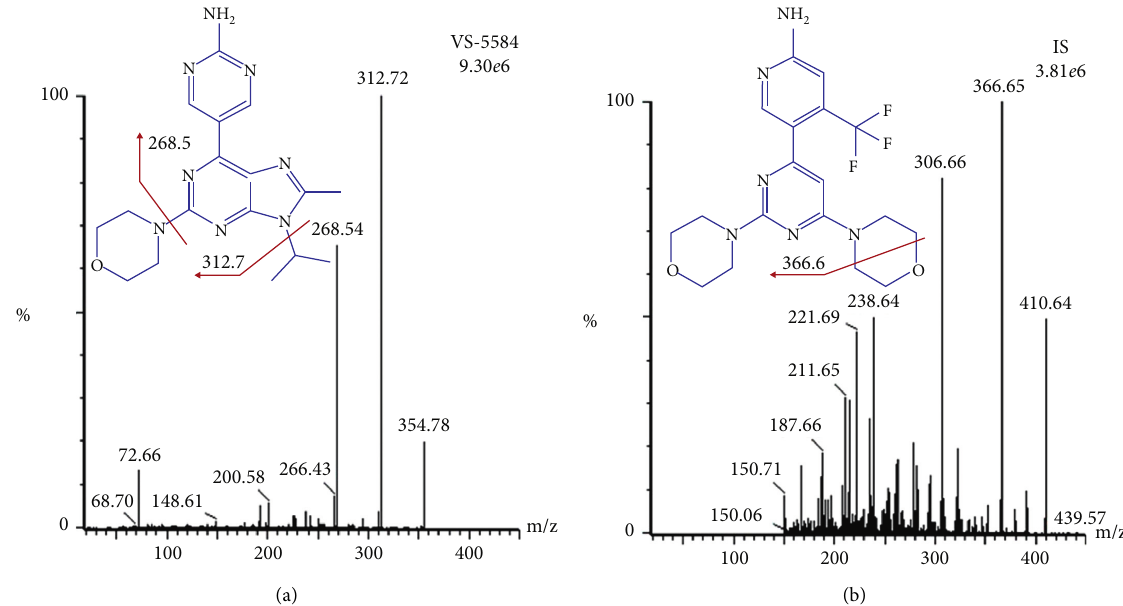
Figure 1: Chemical structures, precursor, and product spectra. (a) VS-5584 and (b) Buparlisib,